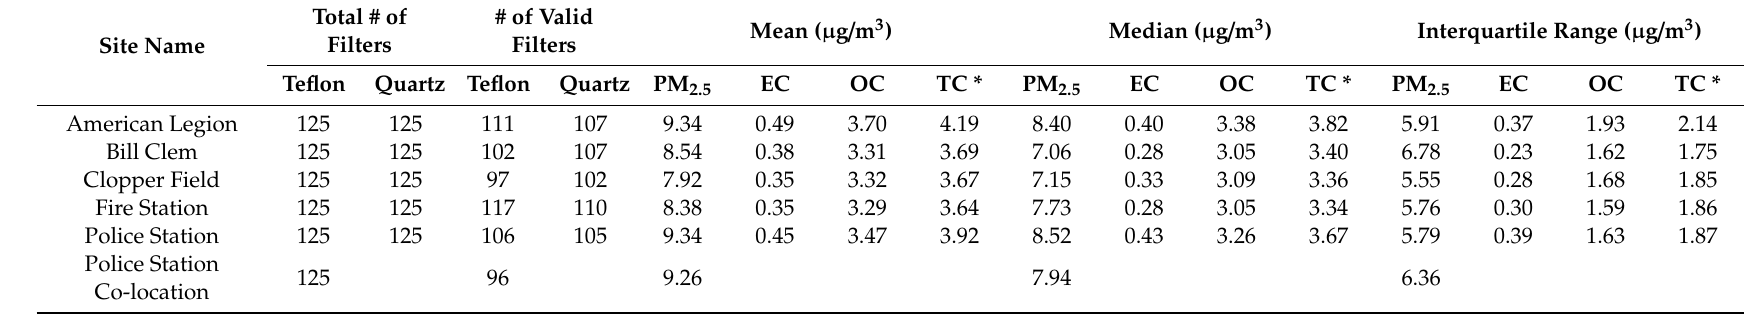
Table 5. Site-Specific Summary Statistics for the 24-hr Integrated Teflon and Quartz Filters (24 October 2017–31 October 2018).